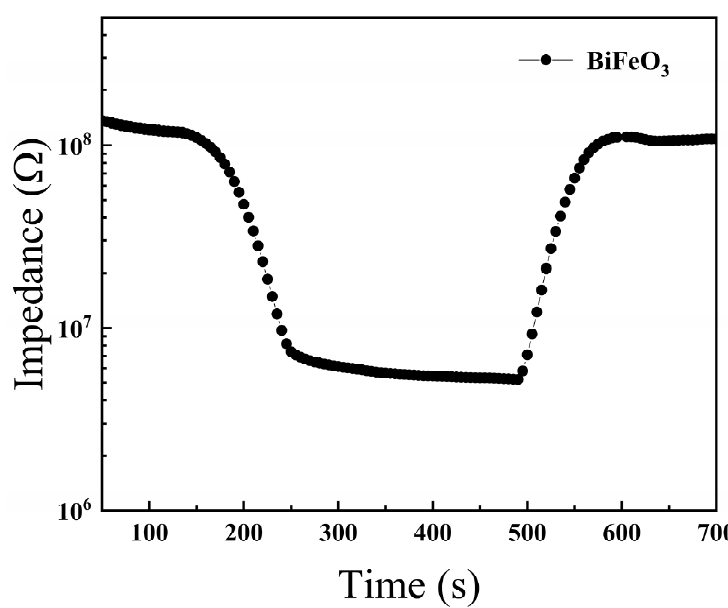
Figure 6. Humidity response and recovery curve of BiFeO 3 film measured at 10 Hz.